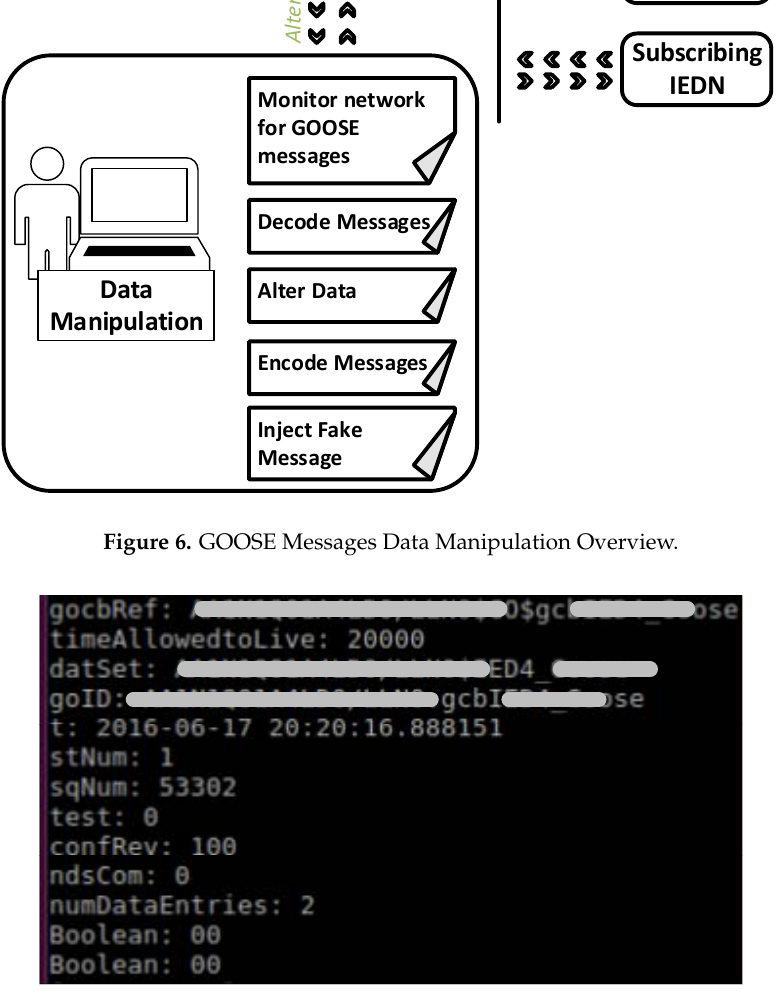
Figure 7. Captured Packet (manufacturer’s details are intentionally omitted).